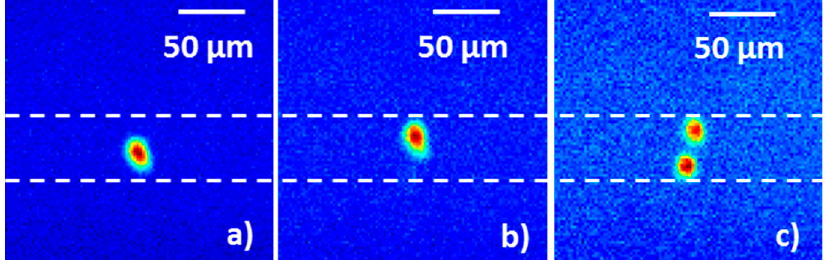
Figure 4. Images of recombination plasma emission (gray-scale images were converted to false color images for better clarity) show spatial displacement of the plasma region. Image ( b ) is delayed 98 µ s with respect to ( a ) and image ( c ) is delayed 53 µ s with respect to (b). Displacement of the plasma region appears to be smaller compared to the longitudinal extend of the striation pattern or the molten zone (compare to Figure 3c). Process parameters: 450 kHz pulse frequency, 3.3 W average power, V feed = 50 mm/s. The white lines are visual aids only, and the laser beam propagation direction is from top to bottom.